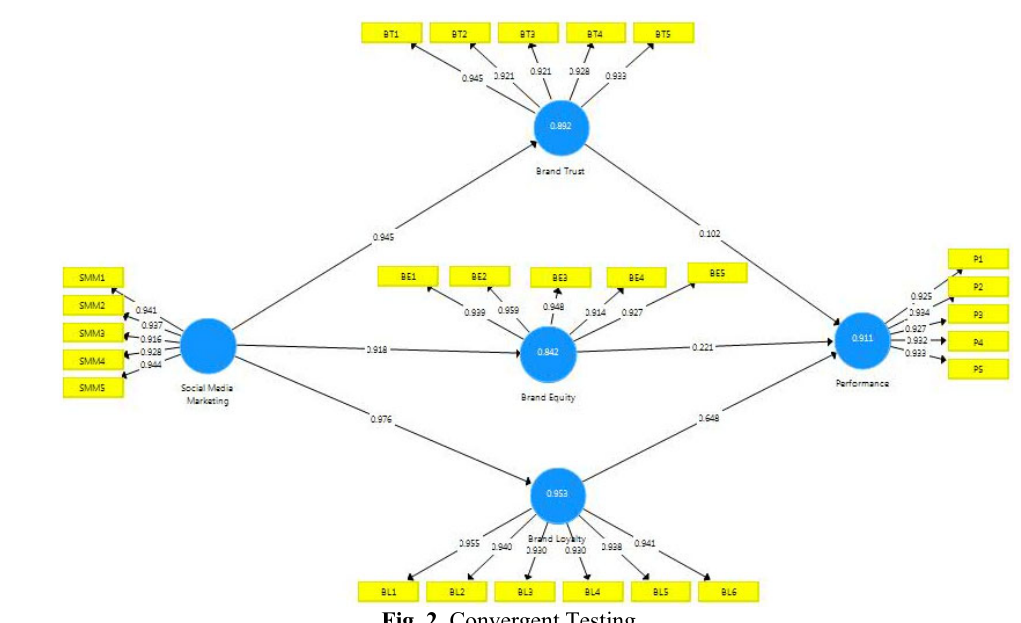
Fig. 2. Convergent Testing